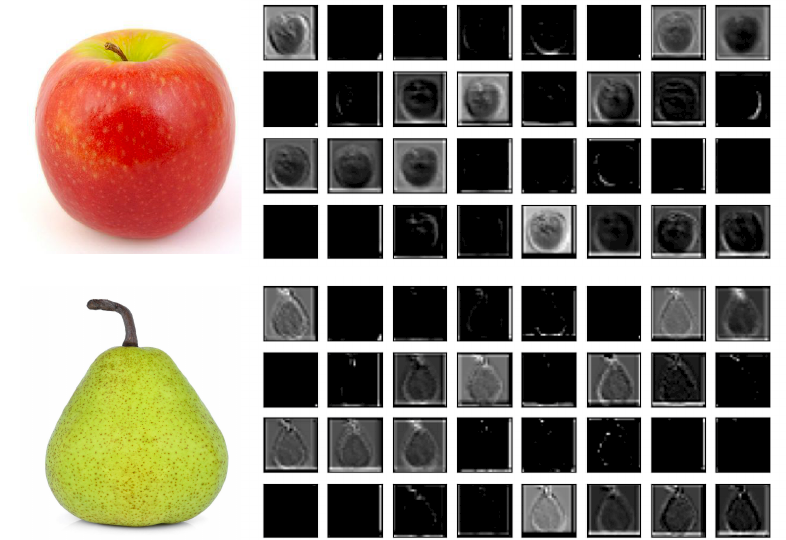
Figure 12. Examples of activation maps of the 3rd convolution layer for two images from Fruit-360 dataset